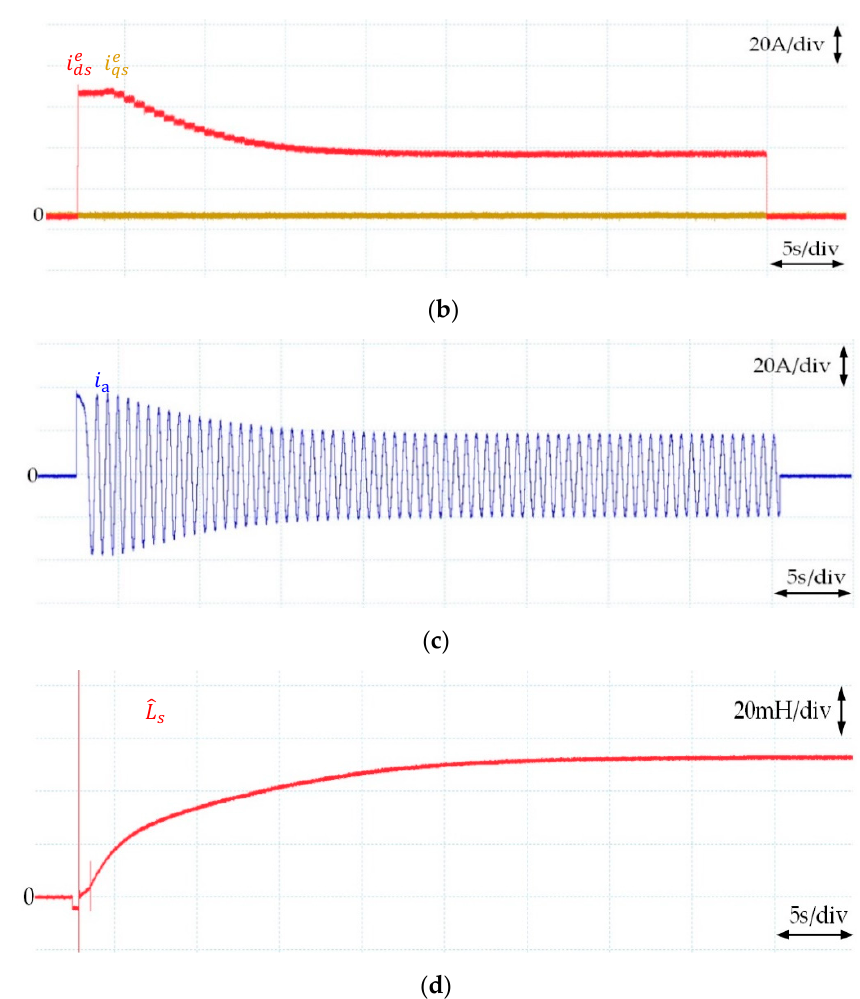
Figure 11. Experiment results for the first motor (18.5 kW/415 V); ( a ) reference and estimated stator flux, ( b ) dq -axis reference and measured currents in a rotating reference frame, ( c ) a-phase current, ( d ) identified stator inductance.